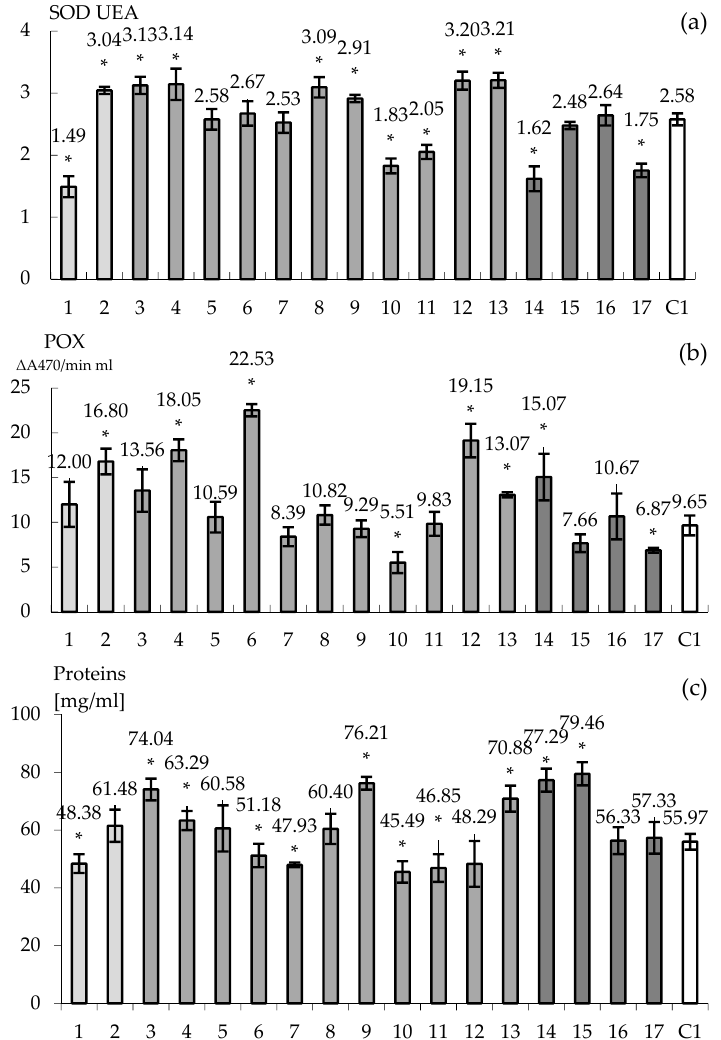
Figure 6. The effect of pre-treatment with ABA and/or PEG on activities of SODs ( a ), POXs ( b ) and total protein content ( c ) of the tobacco plantlets ( N. tabacum L., ‘Baladi’) after 10 days of acclimatization. Significant differences: p < 0.05. The X axe is for evaluating all 17 clones and control C1. * Significant differences: p < 0.05.